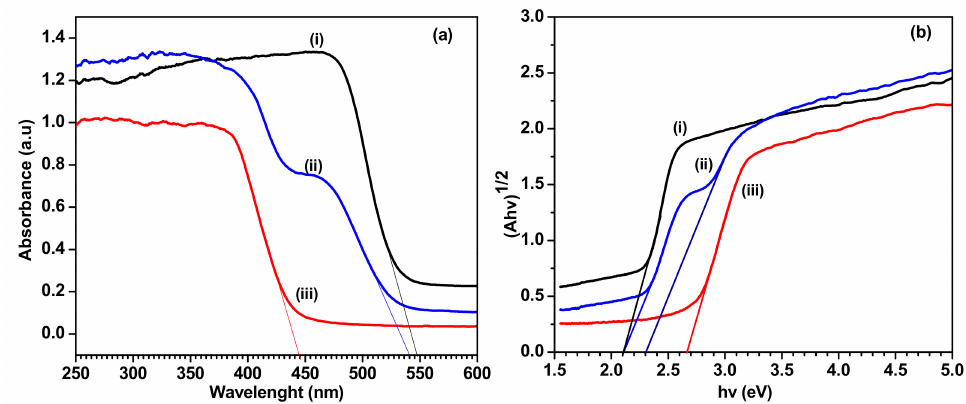
Figure 7. ( a ) UV-vis diffuse reflectant spectroscopy (DRS) spectra and ( b ) band gap energy of (i) Ag 3 PO 4 , (ii) Ag 3 PO 4 /g-C 3 N 4 composite and (iii) g-C 3 N 4